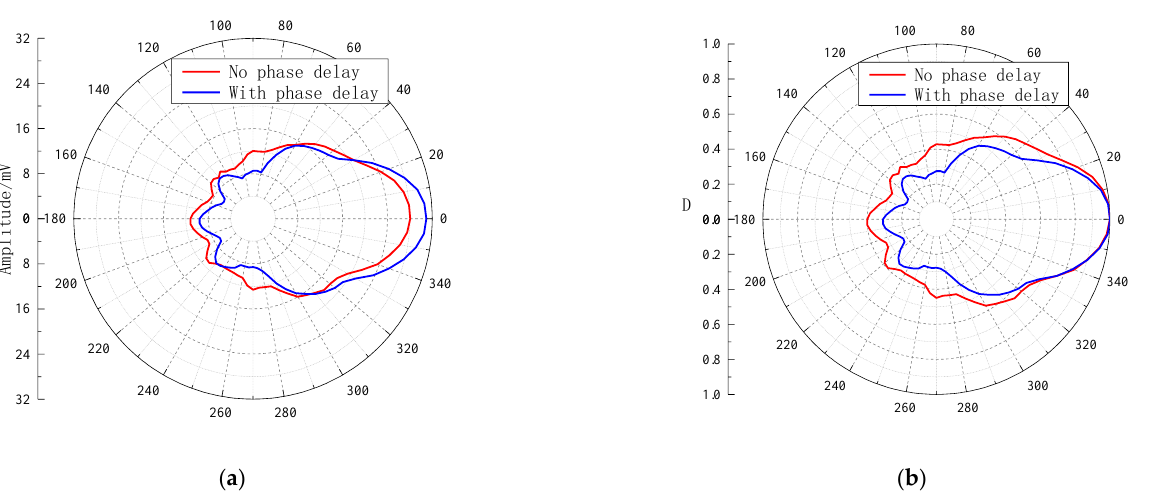
Figure 15. Time-domain waveforms received by the hydrophone when each element in the subarray is applied with an excitation signal, the navy lines represent the time window for extracting waveform amplitude. ( a ) Waveforms with no phase delay of excitation signals and ( b ) waveforms with a phase delay of excitation signals.